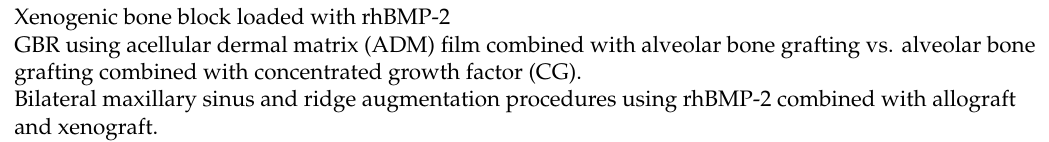
Table 1. Commonly used growth factor